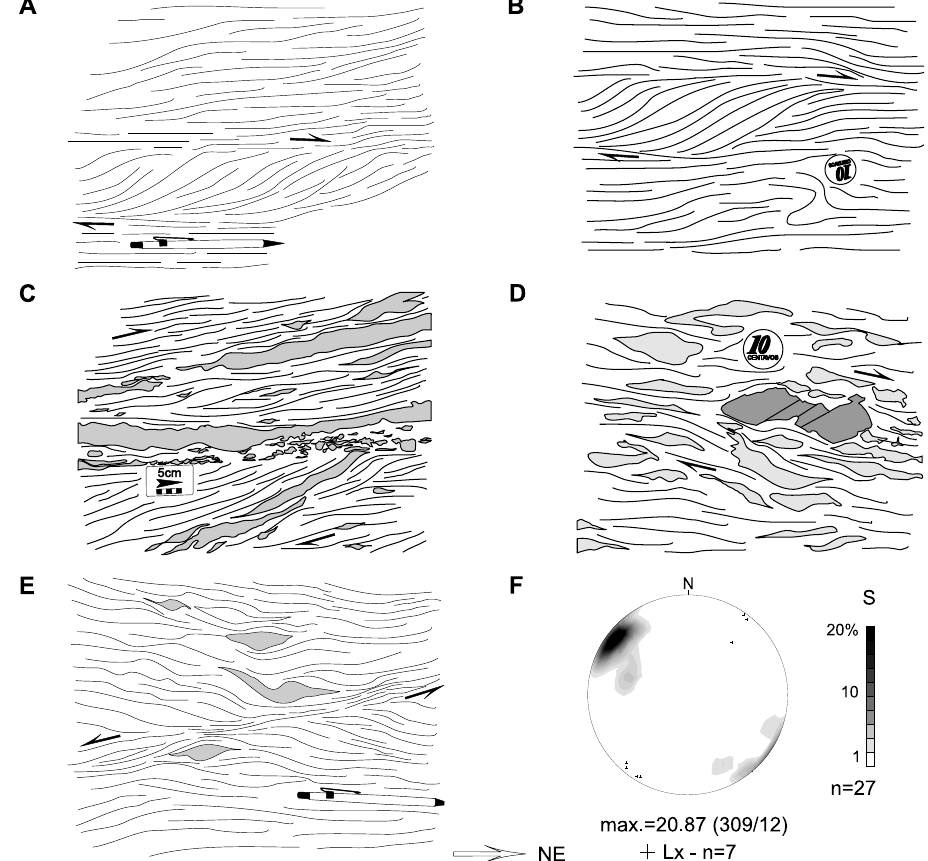
Fig. 10 – Kinematic indicators in granulitic mylonites with steeply dipping structures near the Bom Jesus do Itabapoana road junction. Sections parallel to the XZ plane of the finite deformation ellipsoid whose direction is indicated. A – S-C-C´ foliation fabric; B – S-C-C´ fabric of foliations with S-folds below the coin; C – Leucogranite lenses along the S-C´ planes; D – Feldspar porphyroclast with faulting antithetic to the main dextral movement forming book structures; E – Sigmoids in leucogranit formed under a ductile-fragile regime showing sinistral movement; F – Stereographic projections of foliations (S) and stretching and mineral lineations (Lx). Number of data points (n)